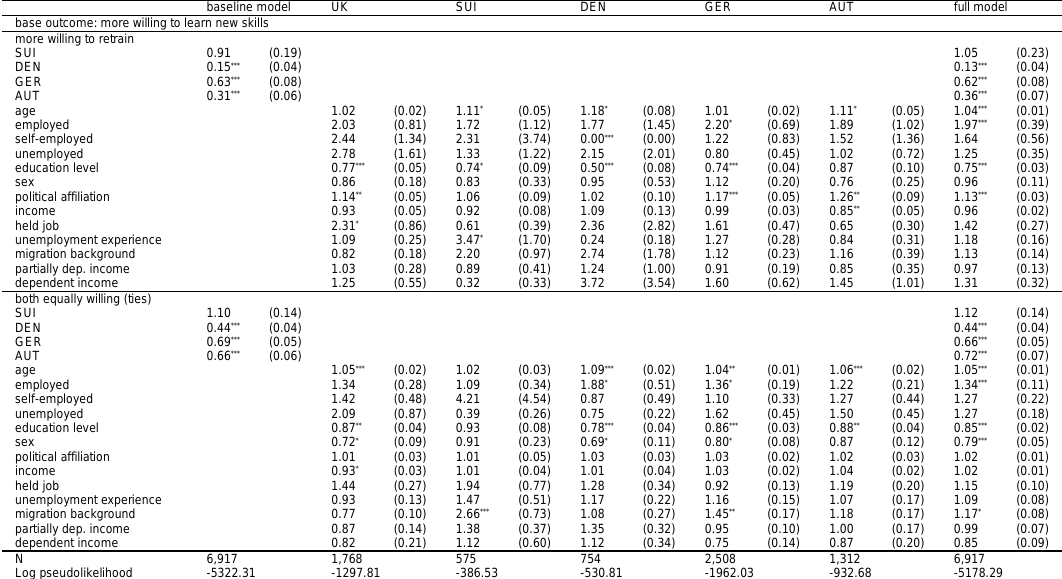
Table 6. Multinomial logistic models for the comparison of willingness to retrain vs. willingness to learn new skills. baseline model UK SUI DEN GER AUT full model base outcome: more willing to learn new skills more willing to retrain